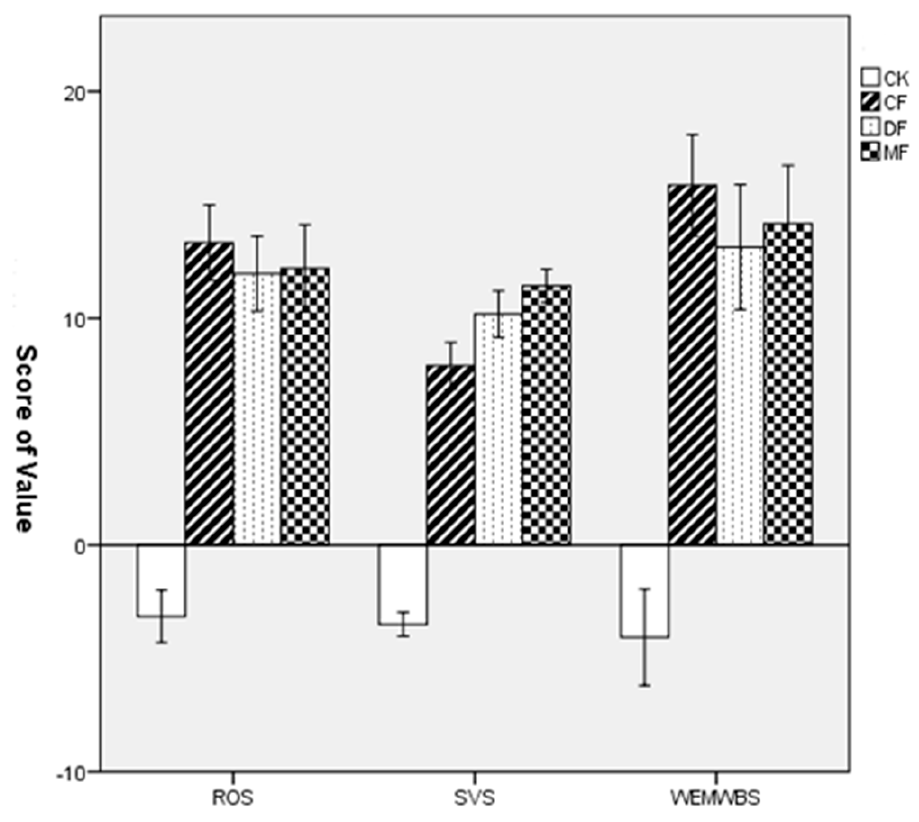
Figure 6. Comparison of the increased values of ROS, SVS, and WEMWBS in the four experimental sites. Data are presented as the mean ± SEs. CK = city site, CF = coniferous forest, DF = deciduous forest, MF = mixed forest. The Spearman rank correlations showed that the level of PRS and the four sub-scales of PRS were positively related to the restoration experience measured by the SBP, DBP, and